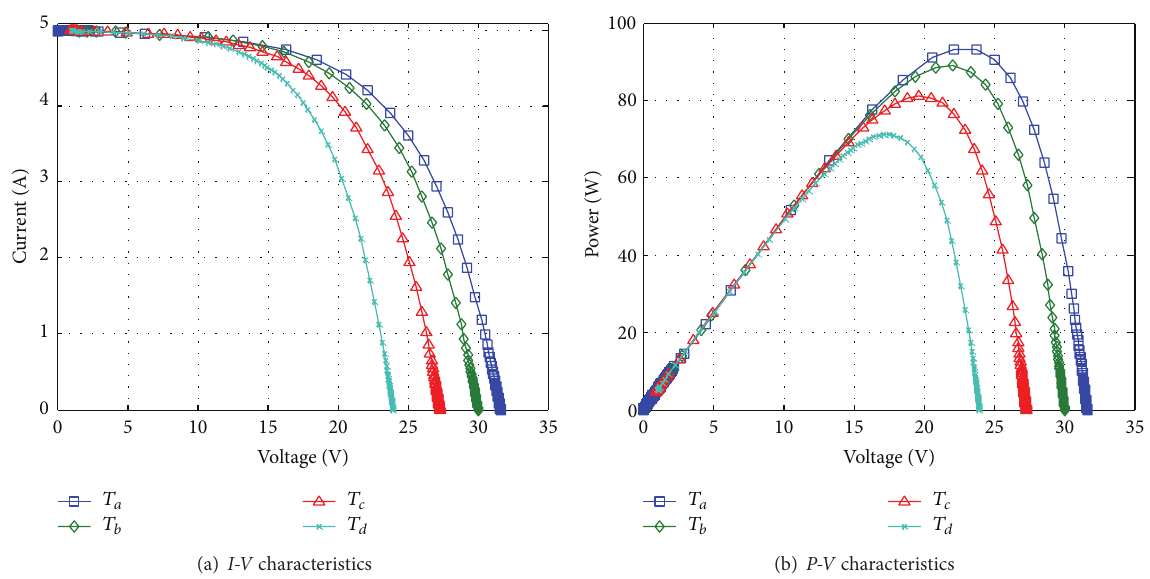
Figure 9: The effect of temperature on I-V and P-V characteristics of the PV